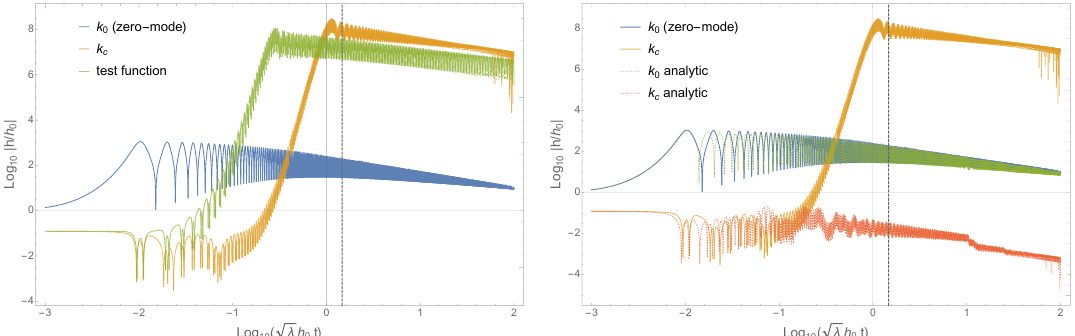
Figure 13 . The evolution of Higgs mode functions with (cid:3) I = 2 : 5 (cid:2) 10 15 GeV and (cid:3) = 2 (cid:2) 10 16 GeV. The results in the left panel are based on smoothed in(cid:13)aton density (3.18). The dotted lines in the right panel are solved by analytic in(cid:13)aton density (A.2) with the mass parameter m (cid:30) = 0 : 05(cid:3) 2 The dashed line is the time when maximum temperature is